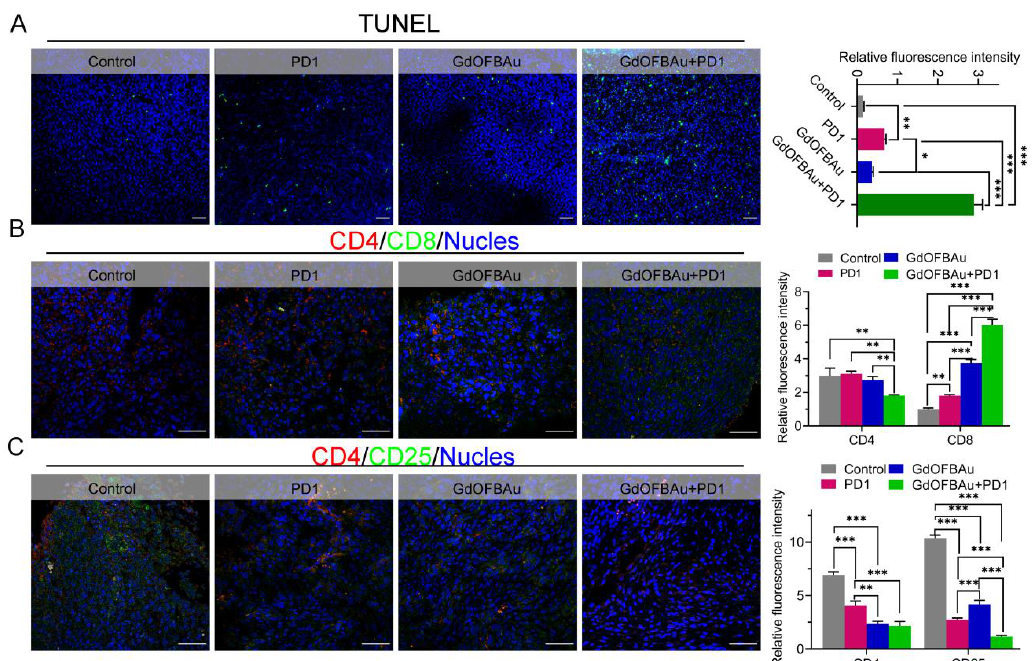
Figure 4. The suppressing effect of GdOFBAu combined with PD1 targeting for MC38 tumors in vivo. ( A ) Schematic diagram of intraperitoneal drug injection. ( B ) Schedule of the tumor vaccination and drug dosing. ( C ) Tumor growth curve of mice bearing MC38 treated with the indicated drug until the termination of the experiment. Photograph ( D ) and weight ( E ) of tumor mass stripped from euthanized mice bearing MC38. p -values were determined by student’s t -test: *** , p ≤ 0.05; ** , p ≤ 0.1; * , p ≤ 0.5.